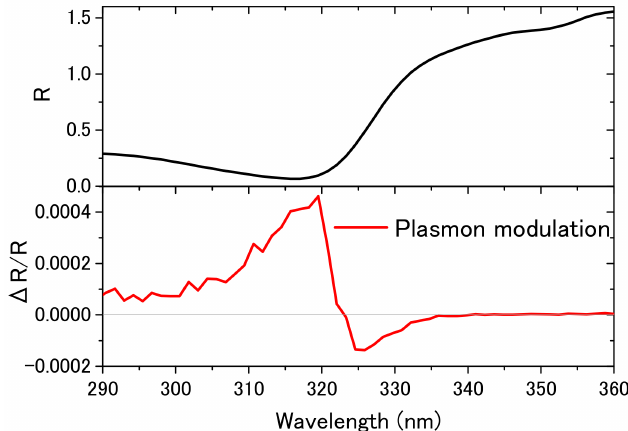
Figure 5. Plasmon modulation spectrum ∆ R/R, which was taken around the interband transition edge from the air side of the prism, while the plasmon resonance dip around 410 nm was excited by a 408-nm